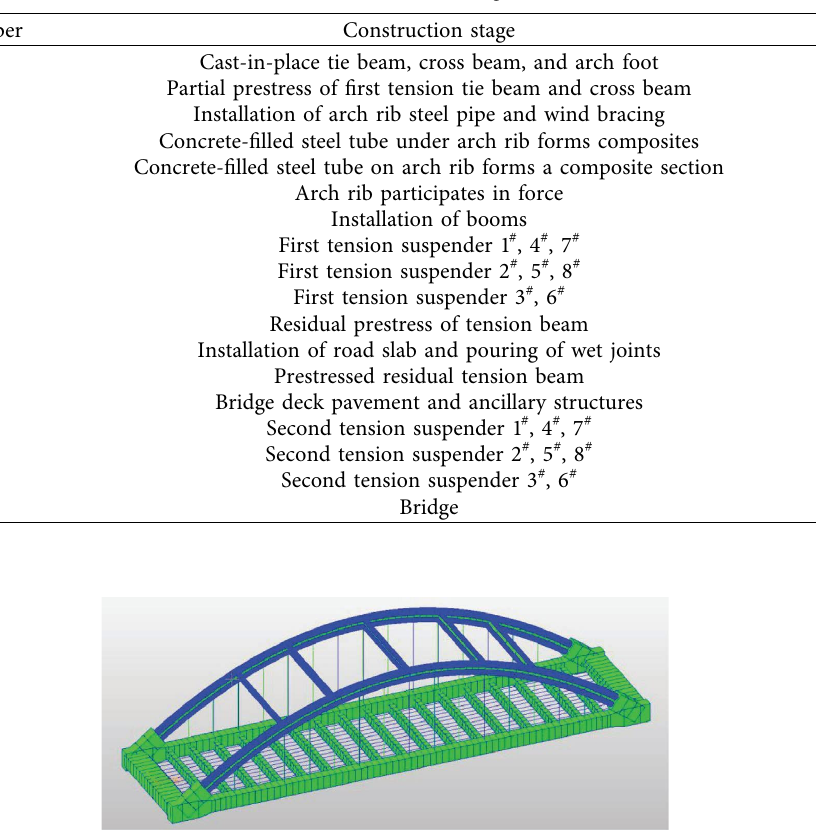
Table 1: Construction stage.